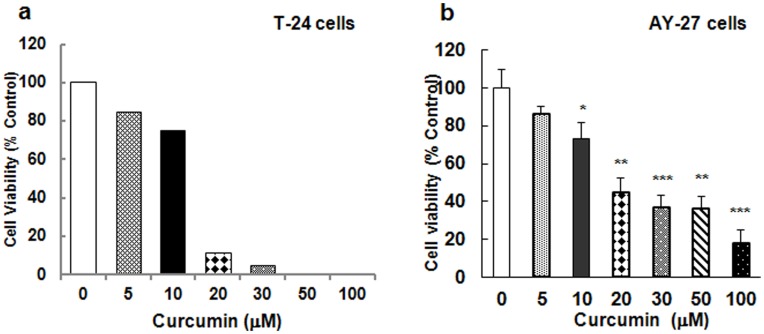
Dose-dependent effects of curcumin on bladder cancer cell proliferation.T-24 (2a) and AY-27 (2b) cells were plated in 12-well plates (0.8×105 cells/well) and cultured for 48 hr (40–50% confluence) as described in Methods. Following exposure to various concentrations of curcumin for 24 h, cells were washed with PBS and incubated for another 24 h in curcumin-free medium. Cells incubated with DMSO (0.1%) alone were treated as controls. DMSO alone had little impact on tumor cell growth (data not shown). Cell proliferation was assessed on the basis of cell viability, measured by MTT assay. Cell viability was expressed as percent of viability observed in DMSO-treated control cells. Values are from a representative (of two) (2a) or 3–8 (mean ± S.E) determinations (2b). *P<0.05, **P<0.01, ***P<0.005.